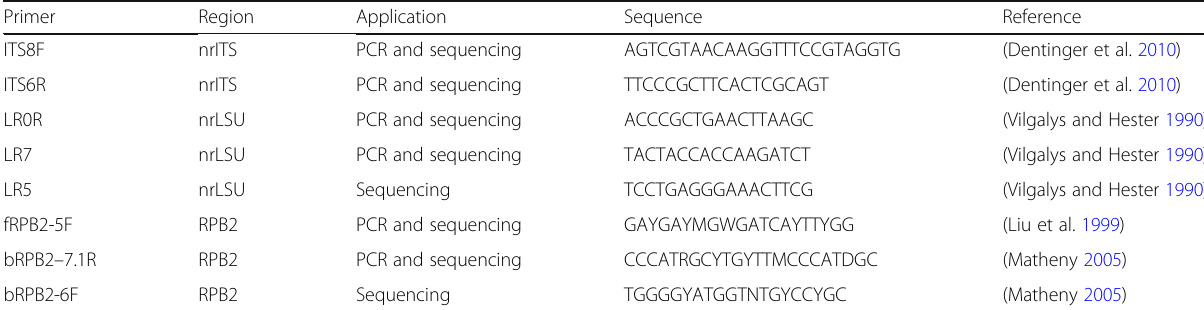
Table 1 Primers used in this study for PCR and sequencing